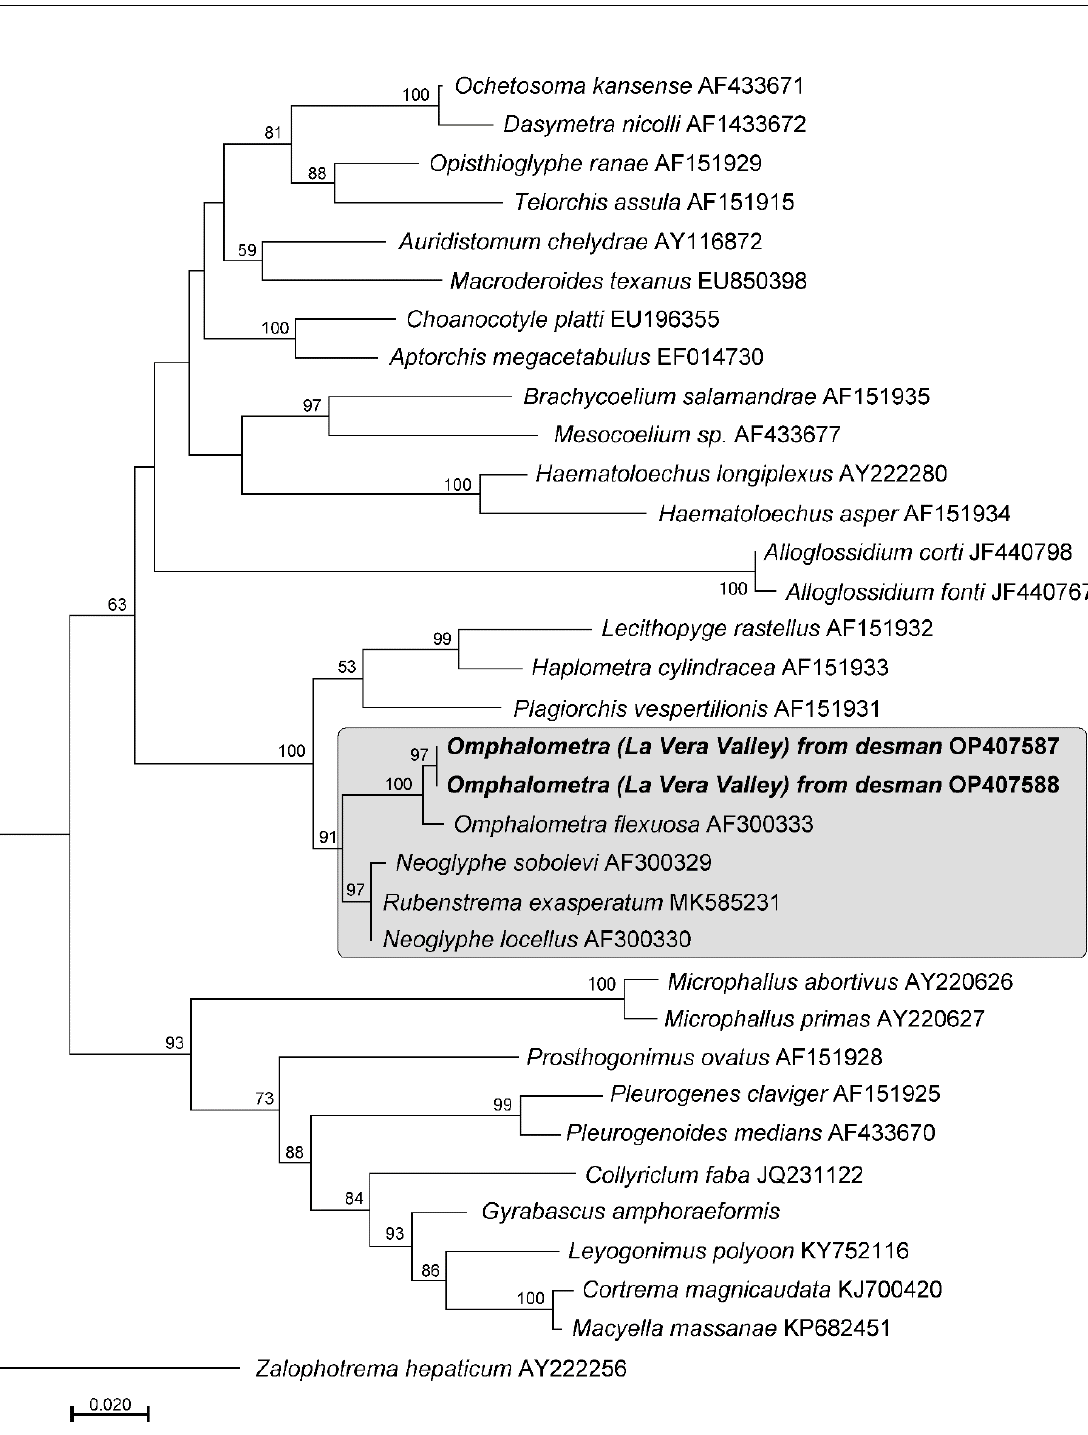
Figure 2. Phylogenetic tree resulting from Maximum Likelihood analysis of 28S rDNA alignment of representative plagiorhioidean and microphalloidean taxa showing the position of Omphalometra spp. from the Pyrenean desman sequenced in our study. The family Omphalometridae is indicated by the shaded rectangle. Numbers above internodes indicate bootstrap support values. Only values >50% are shown. The scale bar indicates the number of substitutions per site.